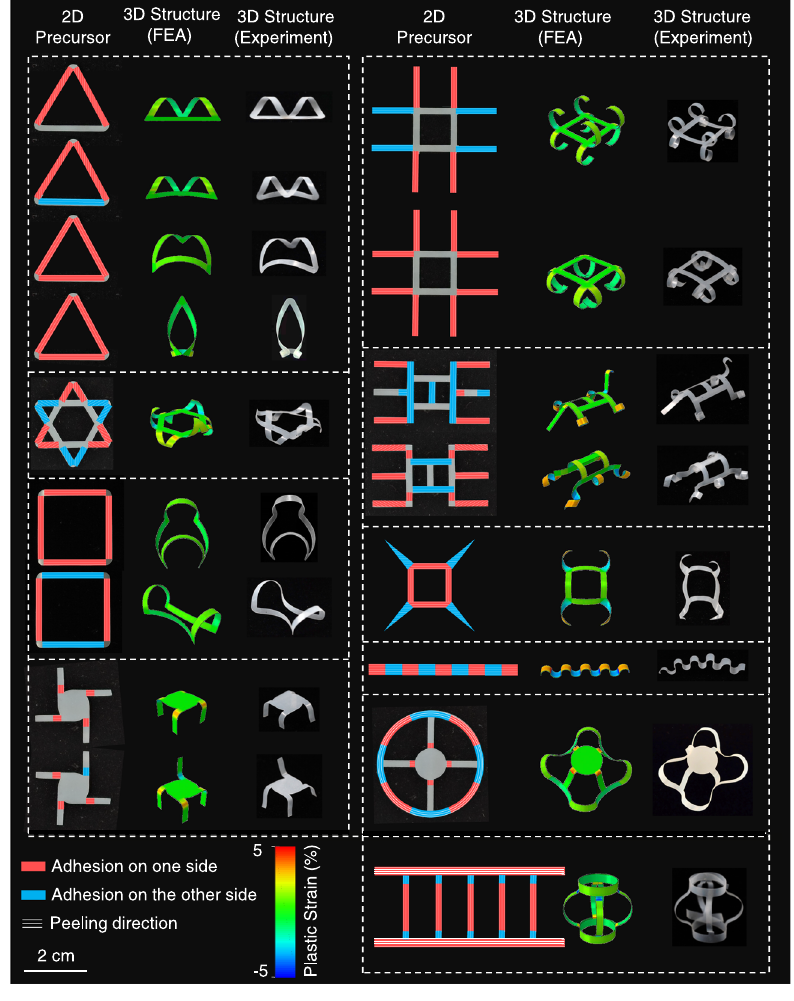
Fig.4|Complex3Dgeometriesprogrammedbydesigningthelayoutofthe2D precursors and regulating the peeling process. Multi-step peeling morphs the 2D precursors of PTFE fi lm into complex 3D geometries by regulating the adhered parts and peeling parameters, including the peeling angle and the